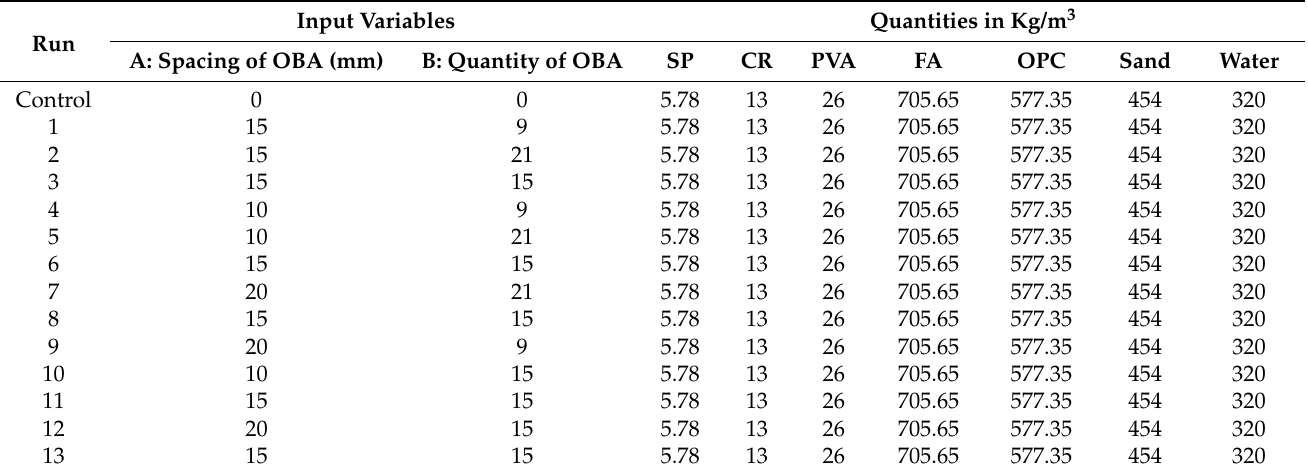
Table 2. RSM variables and mix proportions.